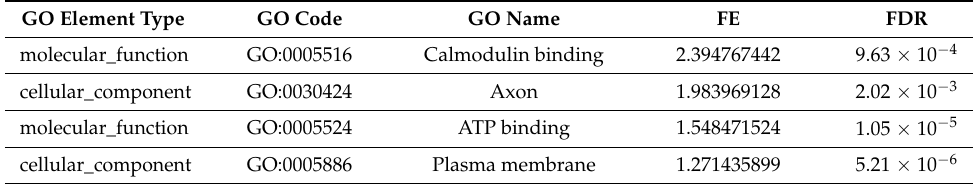
Table 6. Enrichment Analysis for Cluster 6.